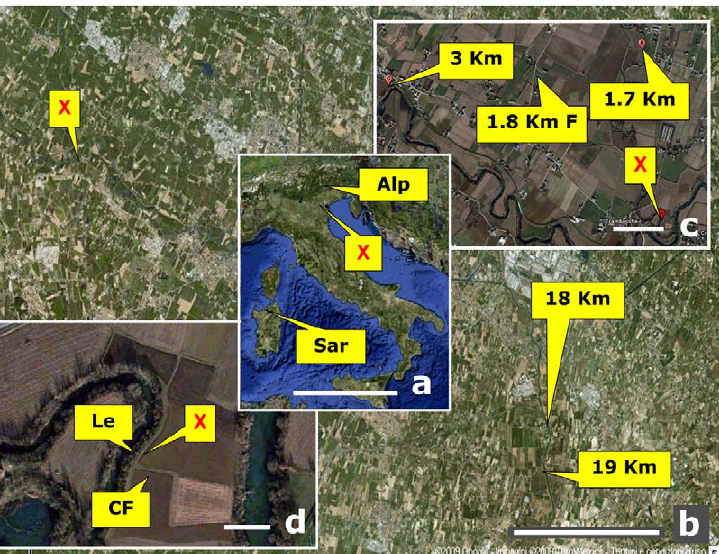
Figure 1. Air view maps of the crime scene and surroundings depicting the sites from which samples were taken, starting from the murder spot, and at increasing distances. The inset map of Italy shows the area location as well as the sites of two soils taken at far distance as outgroup references. X: spot where the corpse was found (margin of a corn field), CF (inside corn field), Le (ridge of the levee bordering the corn field). 1.7 Km, 3 Km, 18 Km, 19 Km: sites located at 1.7, 3, 18, 19 kilometers from the murder site and sharing the same crop (corn); 1.8 KmF: (fallow), site located at 1.8 km but not cropped for over 50 years and featuring natural vegetation and secondary growth. Sar: soil from an uncultivated area in Sardinia (Castelsardo); Alp: soil from an uncultivated area in the Alps (Soranzen). All samples, except the two outgroup references, were chosen in equivalent soil conditions as regards parent material, depositional basin river and soil type (Hypercalcaric-Fluvic Cambisols, WRB 1998, or Oxyaquic Eutrudept fine-silty, carbonatic, mesic, USDA 1998) to minimize the variability that would occur across different soil types. For details and exact coordinates, see Tab.1. Scale bars equal: 500 km (a); 5 km (b); 500 m (c); 50 m (d).